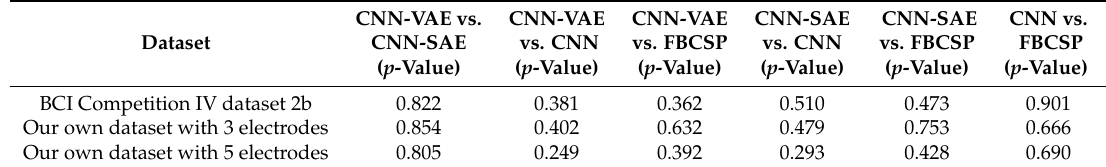
Table 6. The results difference to a normal distribution.